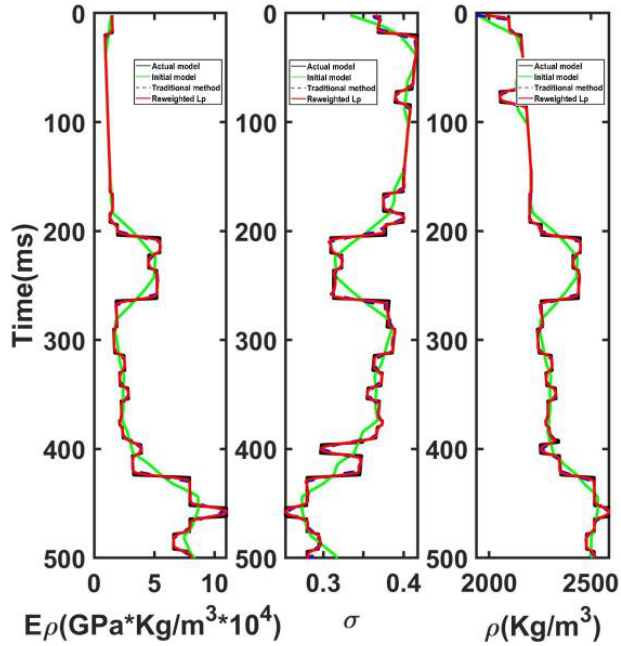
Figure 12. Comparison of inversion results for the 500th trace.